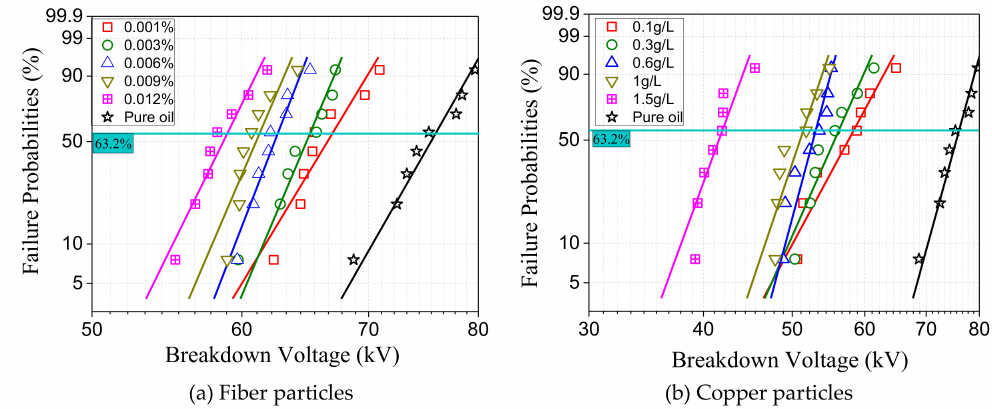
Figure 9. Weibull distribution of breakdown voltage for contaminated mineral oil.